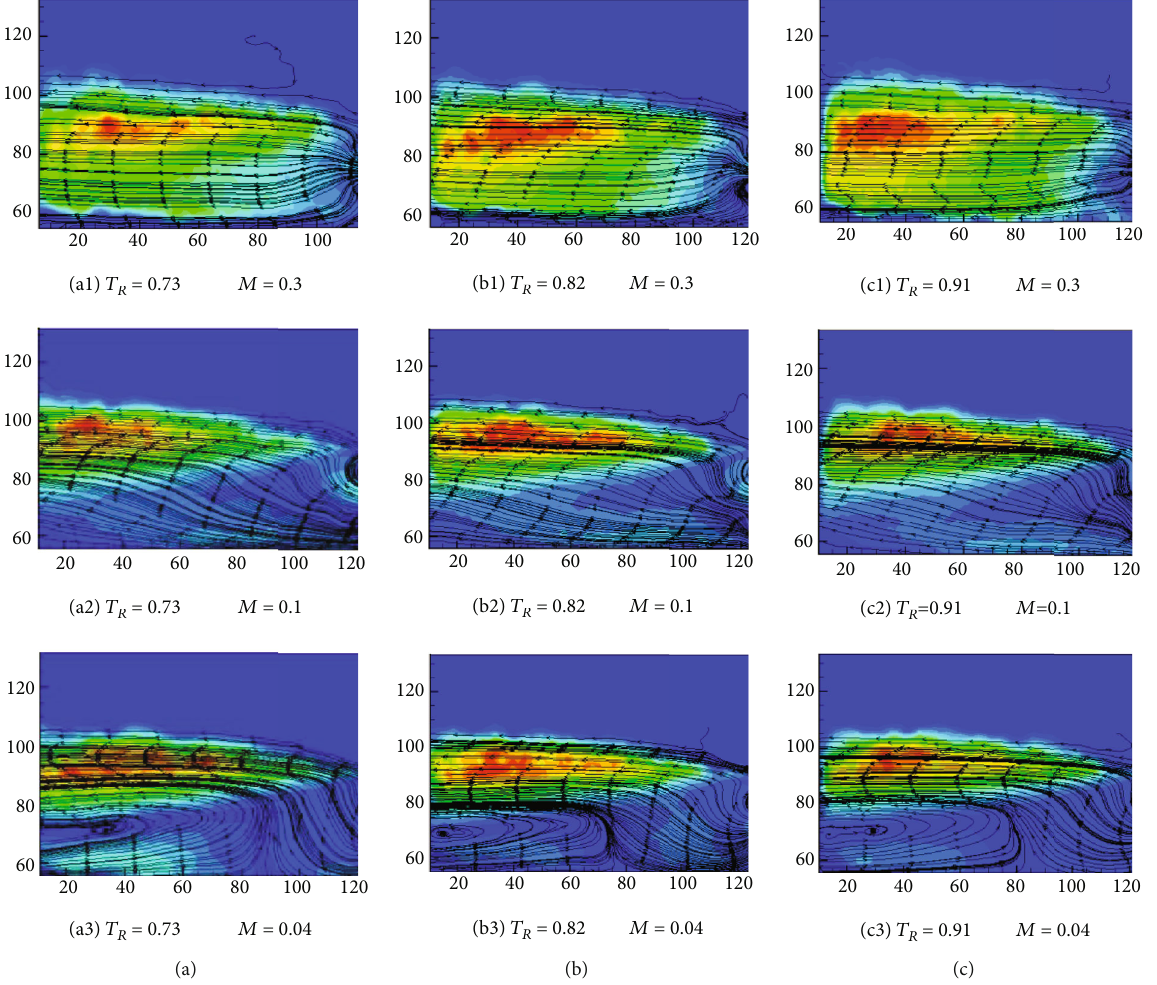
Figure 9: Flow fi eld pattern at di ff erent temperature